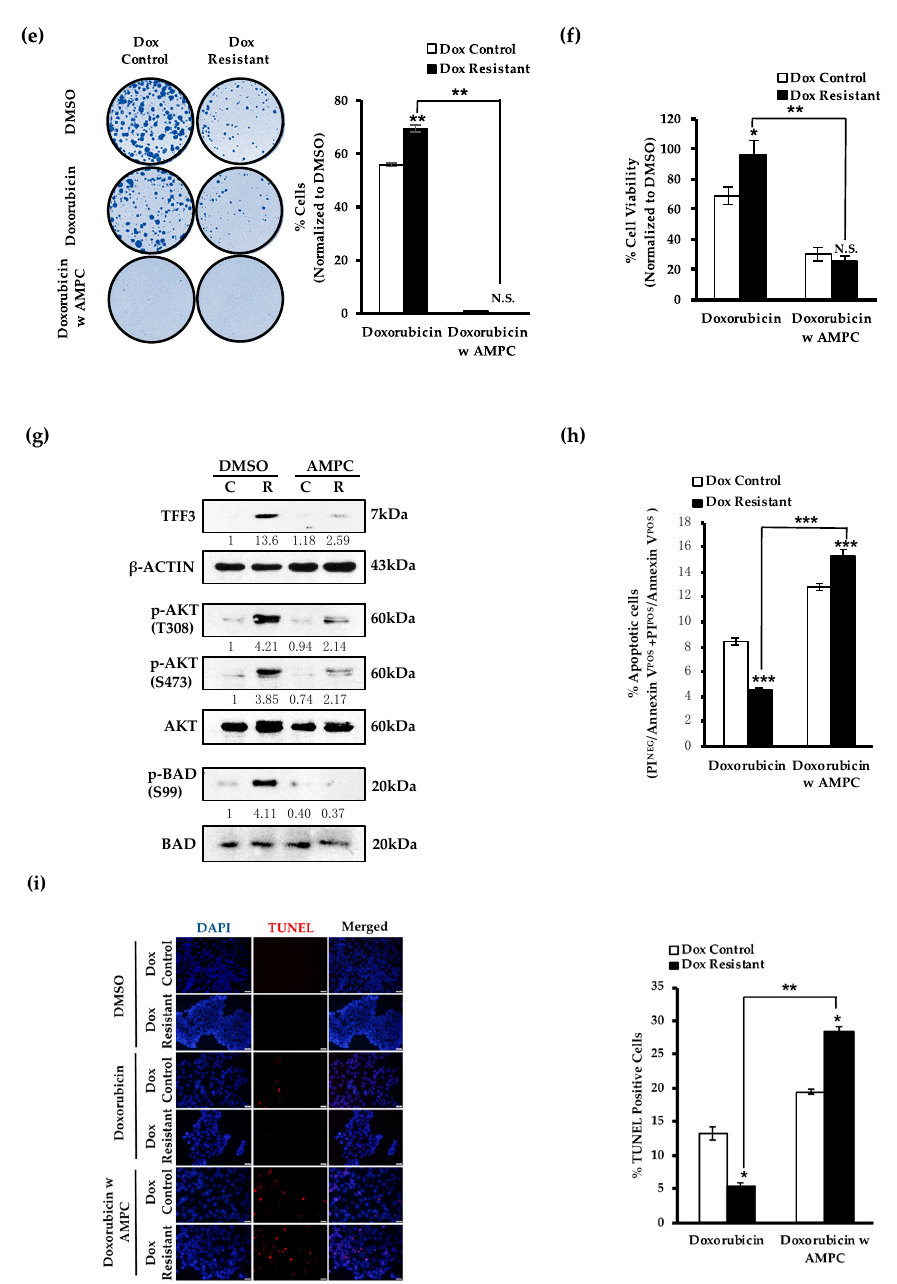
Figure 5. TFF3 inhibition re-sensitizes doxorubicin resistant ER + MC cells to doxorubicin-induced apoptosis. Control and doxorubicin resistant MCF-7 cells ( a ) pre-incubated with 20 nM of two TFF3 siRNA combined or ( b ) co-treated with 1 µ M AMPC were treated with increasing doses of doxorubicin for 72 h in monolayer culture. ( c ) Increasing doses of doxorubicin and AMPC were treated to control and doxorubicin resistant MCF-7 cells at a fixed ratio of 1:20 for 72 h in monolayer culture. Combination index (CI) and dose reduction index (DRI) were tabulated using CalcuSyn software by Chou-Talalay [51]. CI 50–80 and DRI 50–80 denotes average combination index and average dose reduction index respectively at 50–80% cell death. CI > 1 indicates antagonism; CI = 1 indicates an additive e ff ect; and CI < 1 indicates synergism. DRI > 1 is favorable dose reduction that leads to toxicity reduction. ( d – f ). Control and doxorubicin resistant ER + MC cells were treated with doxorubicin with or without AMPC ( d ) for 3 days in monolayer culture (50 nM dox, 1 µ M AMPC); ( e ) in monolayer culture at low cell density until foci formation (25 nM dox, 2 µM AMPC); and (f) for 9 days after 5 days pre-culture in medium containing 5% FBS and 4% Matrigel (100 nM dox, 5 µM AMPC). (g) Western blot analysis for protein levels of TFF3, AKT and BAD after 10 µM AMPC